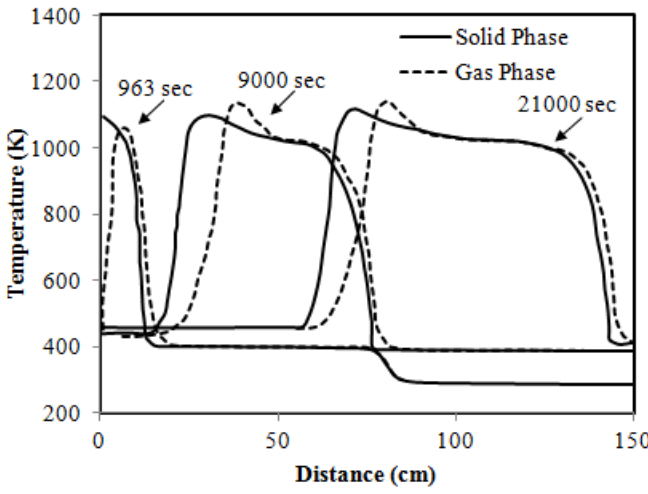
Figure 3. Calculated gas and solid temperature at three different times for the 1.5 m reactor simulation [48].